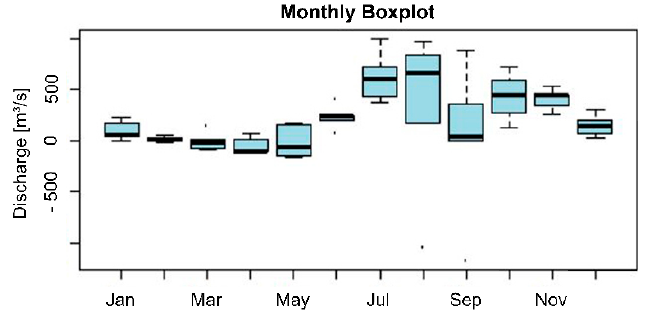
Figure 7. Boxplots of the monthly cumulated discharge difference between correlated and in situ measured discharge for the period from 2002 to 2006.